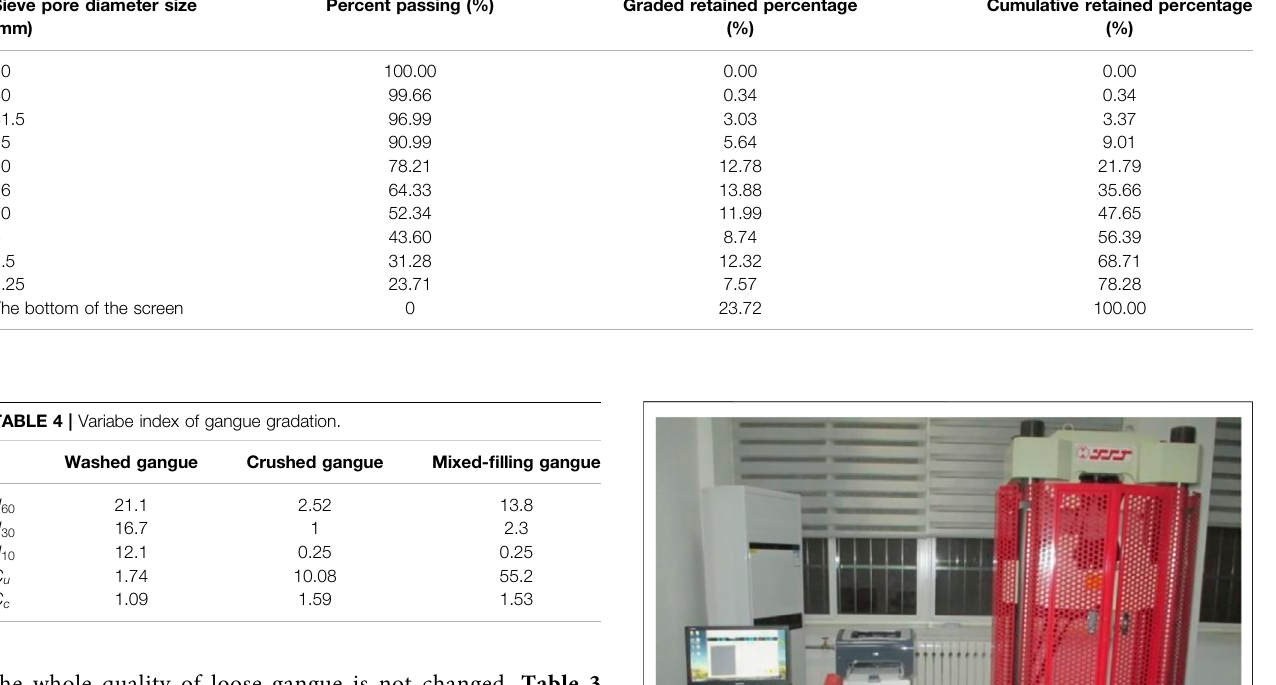
Figure 1 . In the gradation curve of mixed gangue, the particle curve of P d ≤ 20 mm is between the curve of n (cid:1) 0.3 and n (cid:1) 0.5, and only the particle content of P d ≥ 20 mm is